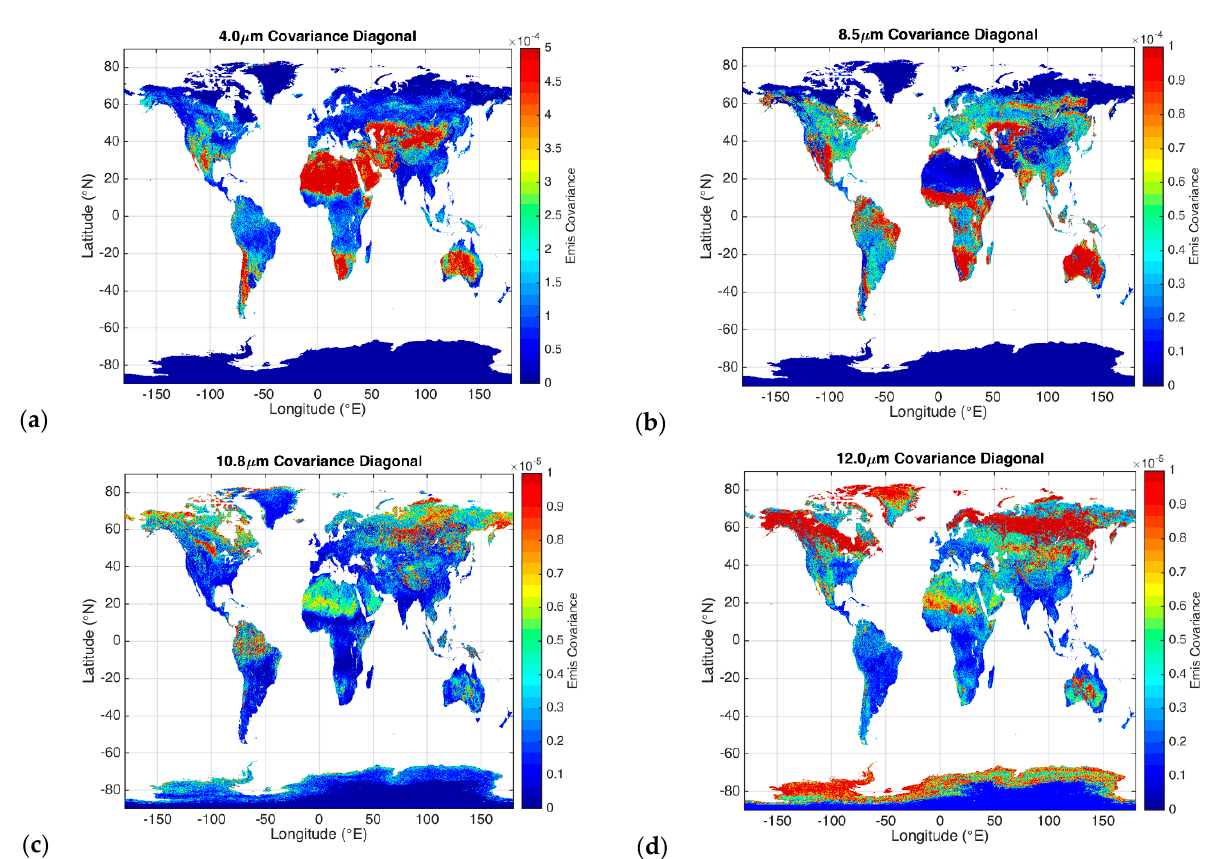
Figure 10. The diagonal of the CAMEL covariance for the month of April at ( a ) 4, ( b ) 8.5, ( c ) 10.8 and ( d ) 12 μ m. The covariance diagonal is computed at 0.25 degree resolution and is available as part of the RTTOV CAMEL V002 climatology emissivity dataset. Note the color scale change between subplots.